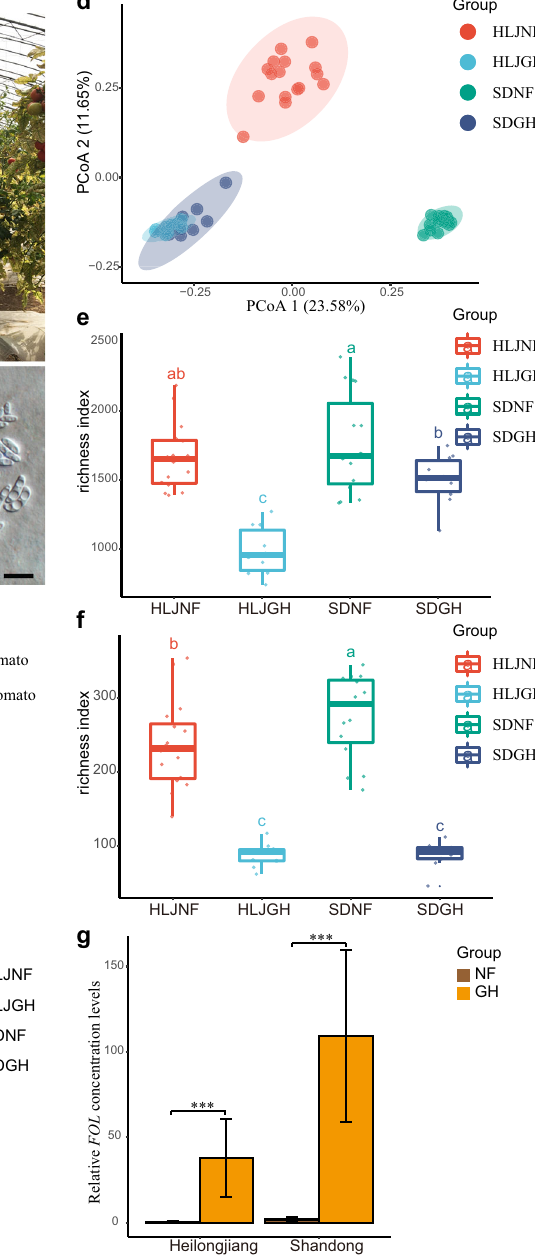
Ellipses cover 80% of the data for each sampling site. e , f Bacterial ( e ) and fungal ( f ) zOTUs richness in tomato rhizosphere samples collected at different sites. Different lowercase letters denote signi fi cant differences between the groups (HLJNF, HLJGH, SDNF,andSDGH)( P <0.05,one-wayANOVAandTukeyHSD).HLJNF, fi eld tomatoof Heilongjiang province; HLJGH, greenhouse tomato of Heilongjiang province; SDNF, fi eld tomato of Shandong province; SDGH, greenhouse tomato of Shandong pro- vince. The number of samples per group is as follows: HLJNF ( n =16 biologically independent plants), HLJGH ( n =10 biologically independent plants), SDNF, ( n =15 biologically independent plants), and SDGH ( n =10 biologically independent plants). The horizontal line within boxes represent medians, tops and bottoms of boxes representthe75thand25thpercentiles,andupperandlowerwhiskersextendtodata nomorethan1.5timestheinterquartilerangefromtheupperedgeandloweredgeof the box, respectively. g Comparison of FOL levels in NF and GH tomato plants from Heilongjiang and Shandong Provinces ( n =5 biologically independent plants). Data barsrepresentmeans,anderrorbarsrepresentthestandarderrorofmean(s.e.m).*** indicate signi fi cant differences between NF and GH groups at P <0.001 (two-sided Wilcoxon rank-sum